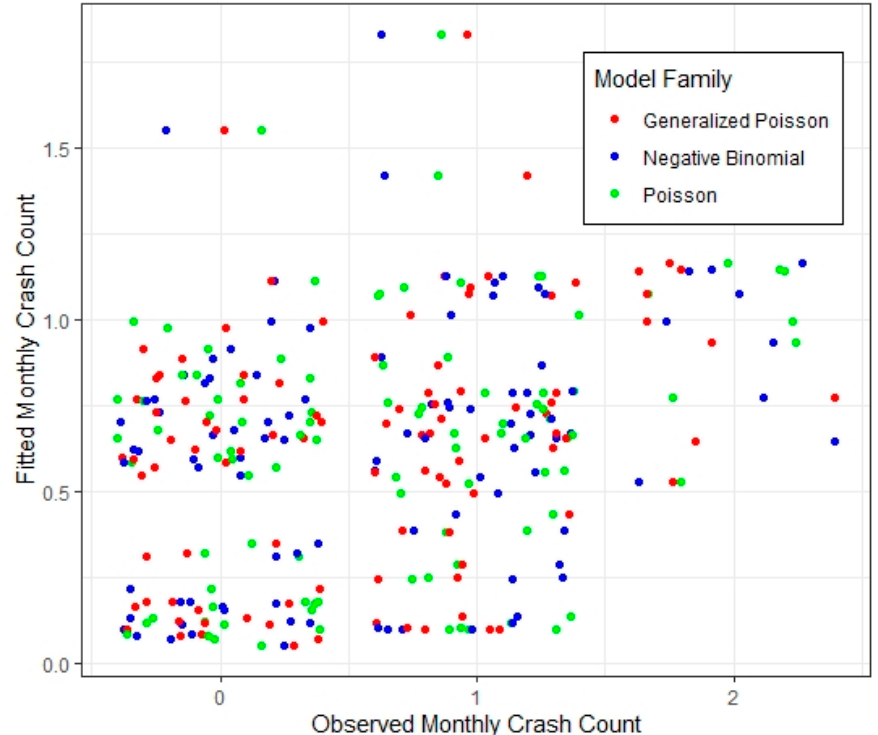
Figure 5. Intersection fitted crash counts versus observed crash counts with outliers removed.